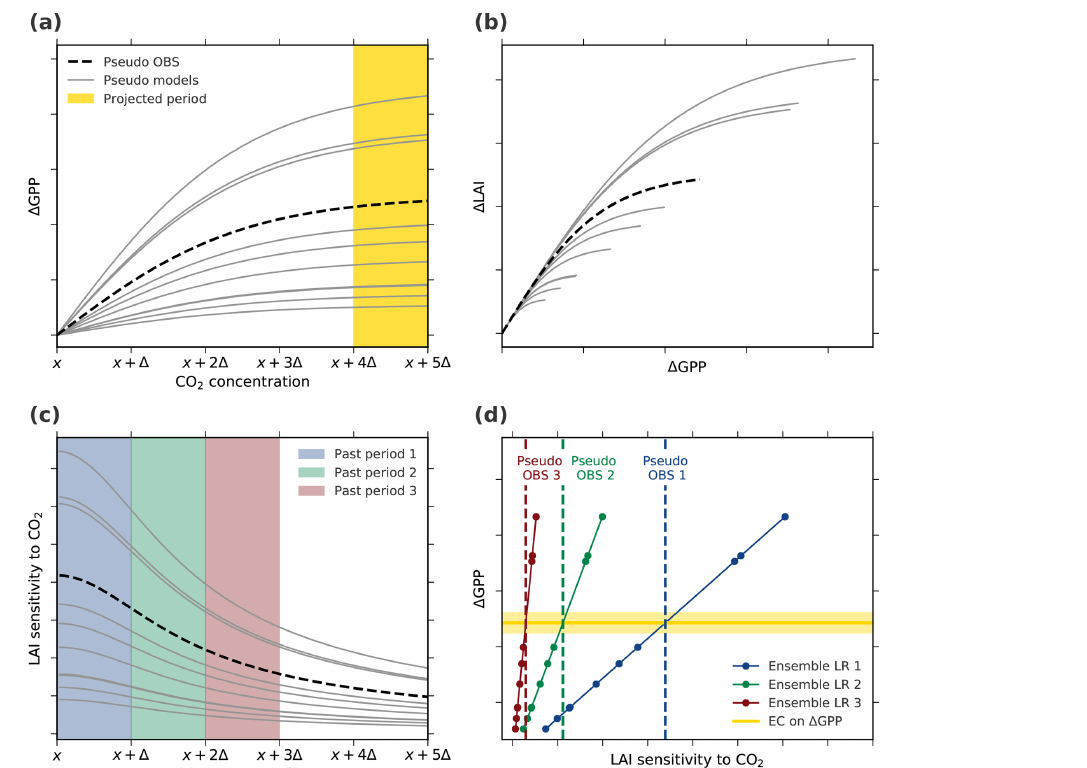
Figure A6. Thought experiment to examine the applicability of the EC analysis assuming an idealized nonlinear–nonlinear behavior of the system (Case 4, Table A1). (a) (cid:49) GPP decreases with increasing CO 2 concentration (described by a hyperbolic tangent function). The yellow band marks the projected period of interest, i.e., the period of CO 2 concentration from x + 4 (cid:49) to x + 5 (cid:49) . (b) Also, (cid:49) LAI decreases with increasing GPP (described by a hyperbolic tangent function). The parameterization in the hyperbolic tangent functions for pseudo observations (dashed black line) as well as models (solid gray lines) is determined randomly for each model. (c) The diagnostic variable, LAI sensitivity to CO 2 , decreases with increasing CO 2 as a consequence of the overall saturating characteristics of the system. The colored bands indicate three “past” periods from x to x + (cid:49) (blue), x + (cid:49) to x + 2 (cid:49) (green), and x + 2 (cid:49) to x + 3 (cid:49) (red). (d) Linear relationships among the pseudo model ensembles (Ensemble LR, colored lines) between LAI sensitivity to CO 2 of the three past periods and (cid:49) GPP from the projected period. Colored dots mark different models and the dashed lines represent associated pseudo observations for the respective historical period. The solid yellow line depicts the constant EC on projected (cid:49) GPP irrespective of the past